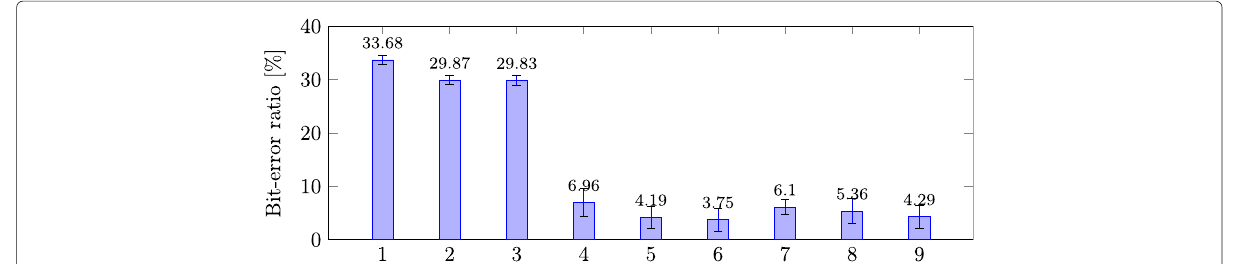
Fig. 9 The 9 cache sets that are used by a 4096b key and their error rate when recovering the key from a single